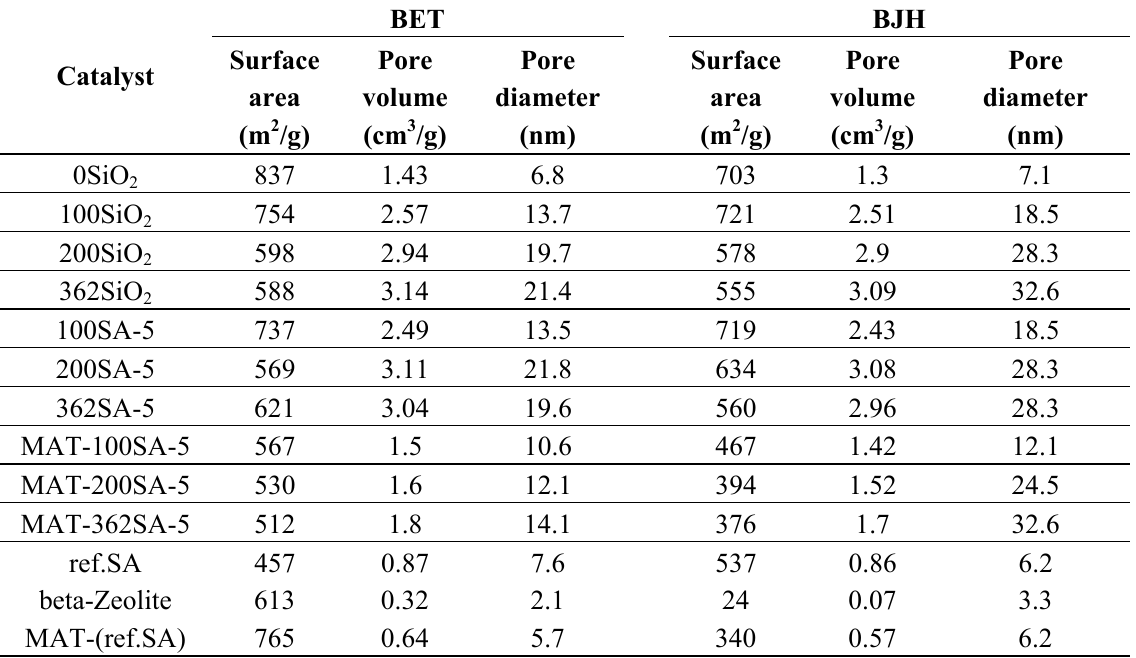
Table 1. Surface areas, pore volumes and pore diameters of silica, silica-alumina, zeolite and mixed catalysts. In naming samples, the weight ratio of 100, 200 or 362 of reinforcing TEOS against 100 of TEOS silica precursor was represented in front of SiO silica-alumina samples, SA was used instead of SiO and the binder, MAT- was represented in front of sample name of